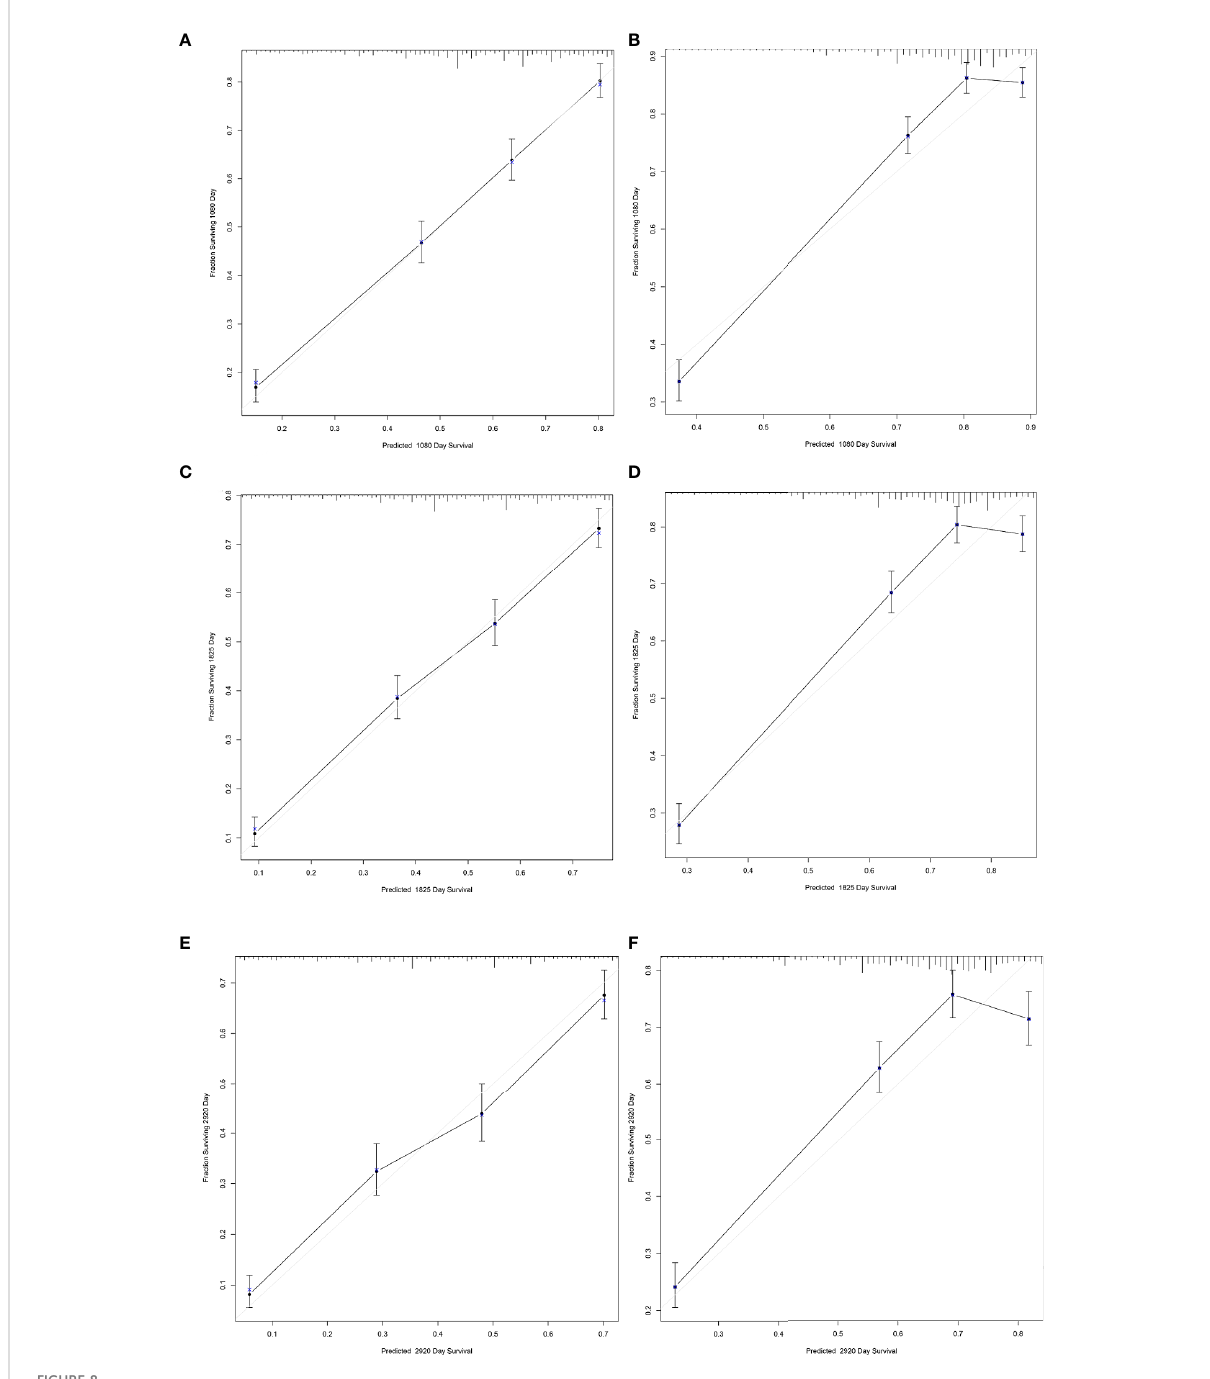
FIGURE 8 Calibrationcurvesforpredicting3-, 5-, and8-yearsurvival of patientswithCCwithLNM. (A, C, E) forinternal validation; (B,D,F) forexternal veri fi